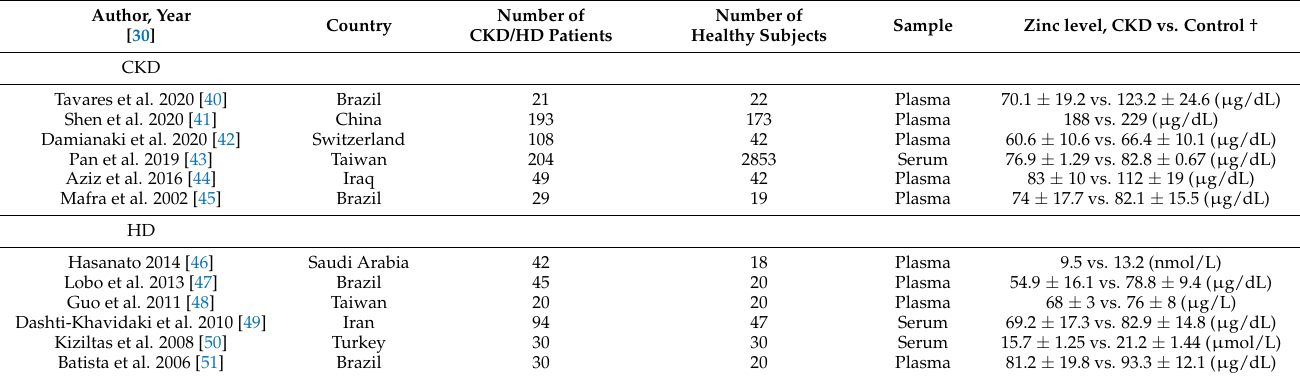
Table 1. Summary of observational studies regarding zinc deficiency in patients with CKD. Country